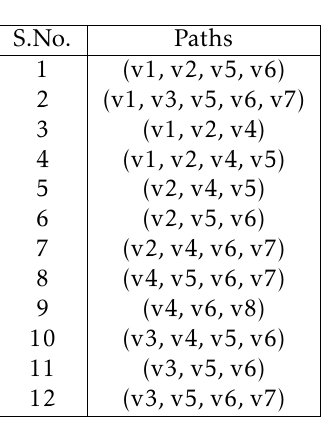
Table 2. Data of Paths